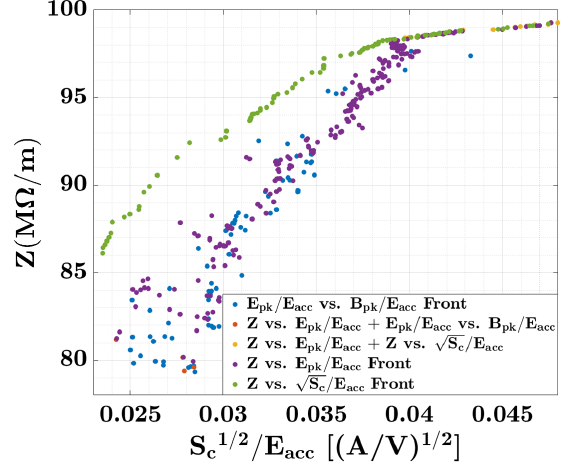
p ffiffiffiffiffi =E S FIG. 11. Z vs objective space. Points that fall on the Z c acc =E =E =E vs E , E vs B , and multiple fronts are pk acc pk acc pk acc